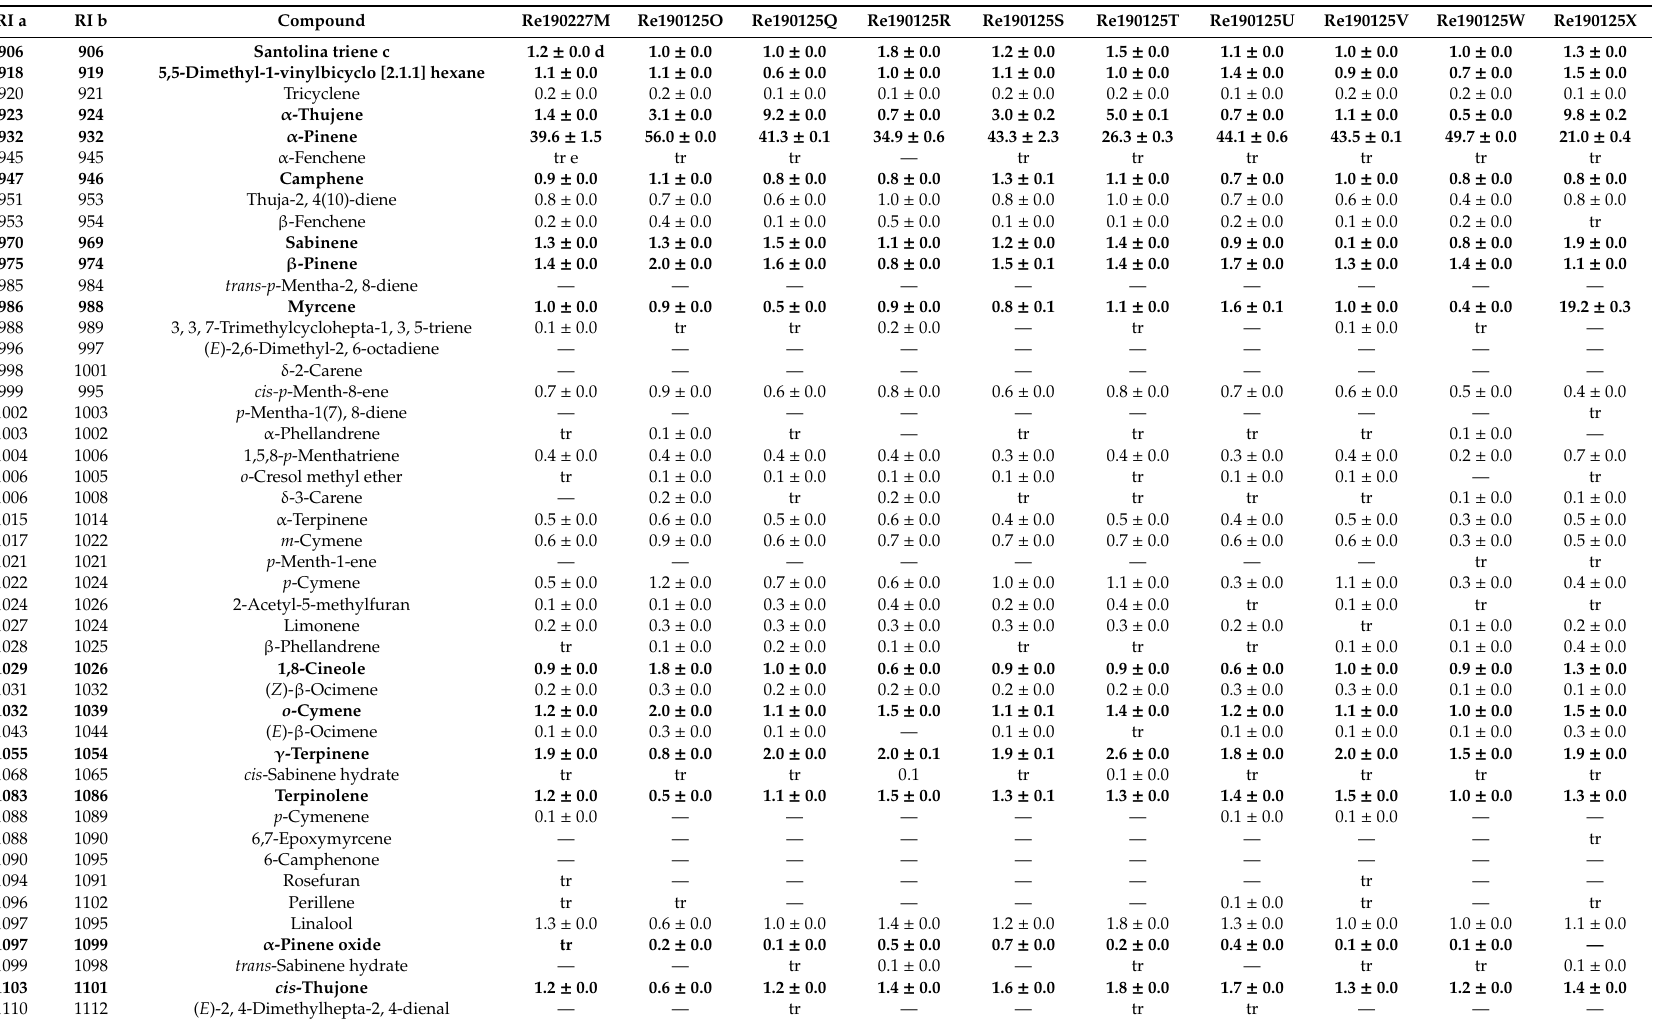
Table 1. Chemical compositions of Boswellia dalzielii oleogum resin essential oils from Burkina